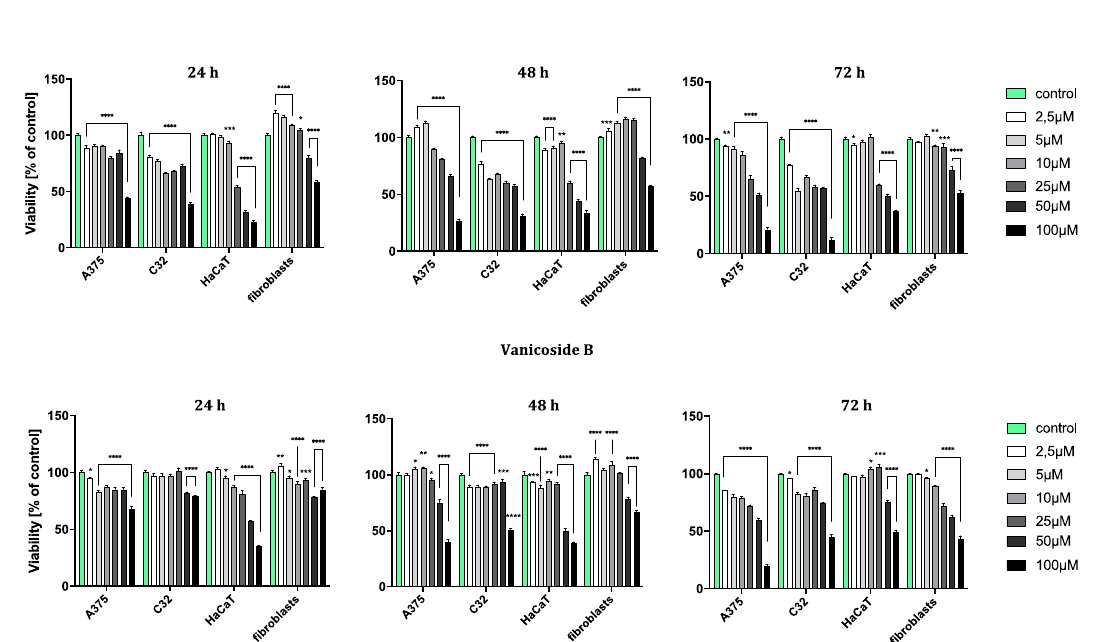
Figure 2. Viability of A375, C32, HaCaT and fibroblast cell line after 24, 48 and 72 h incubation following increasing concentrations of vanicoside A and vanicoside B. The mitochondrial metabolic function (viability) was expressed as a percentage of viable treated cells in relation to untreated control cells. Error bars shown in this figure are means ± SD for n ≥ 3. * Statistically significant at p ≤ 0.05, ** for p ≤ 0.01, *** for p ≤ 0.001, **** for p ≤ 0.0001. Formazan product from an MTT assay was not detectable for staurosporine (positive control) in any tested cell line.